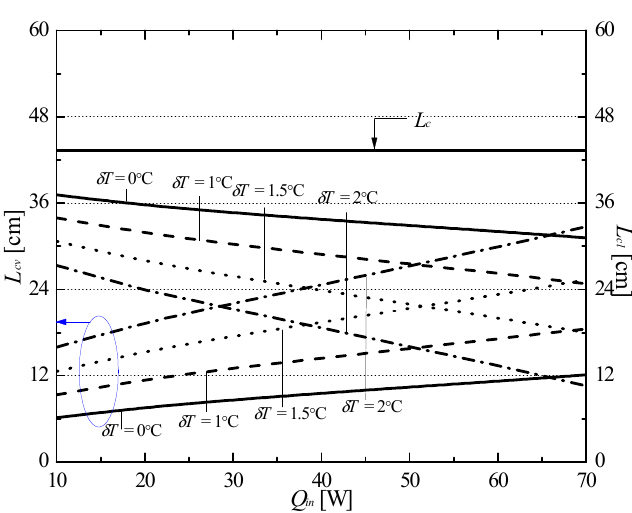
Figure 13. Variations in L cv and L cl as functions of thermal load.